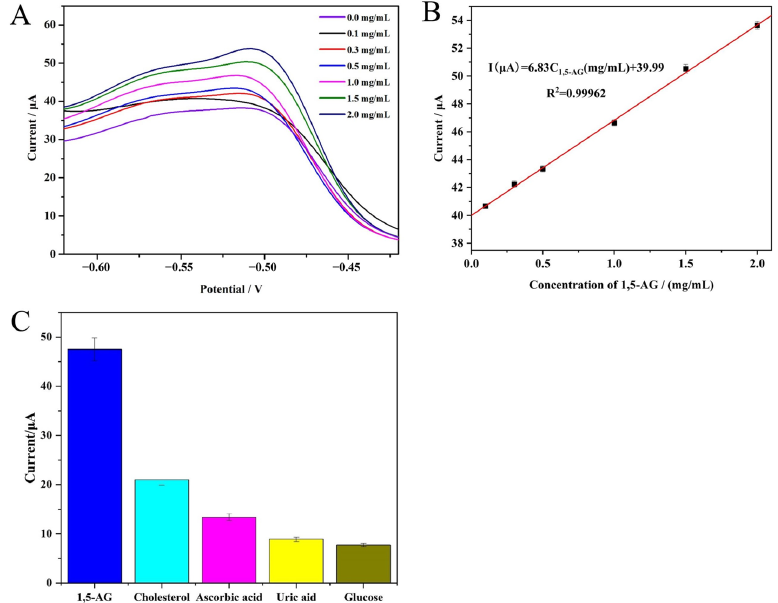
Figure 5. ( A ) The DPV plots of 1,5-AG at increasing concentrations from 0.1 to 2.0 mg/mL were obtained by using the 1,5-AG electrochemical biosensor. ( B ) The linear calibration curve of the electrochemical biosensor in the range of 0.1 to 2.0 mg/mL of 1,5-AG. ( C ) The histogram of the specificity of the proposed 1,5-AG electrochemical biosensor. The error bars represent the RSD ( n = 3).